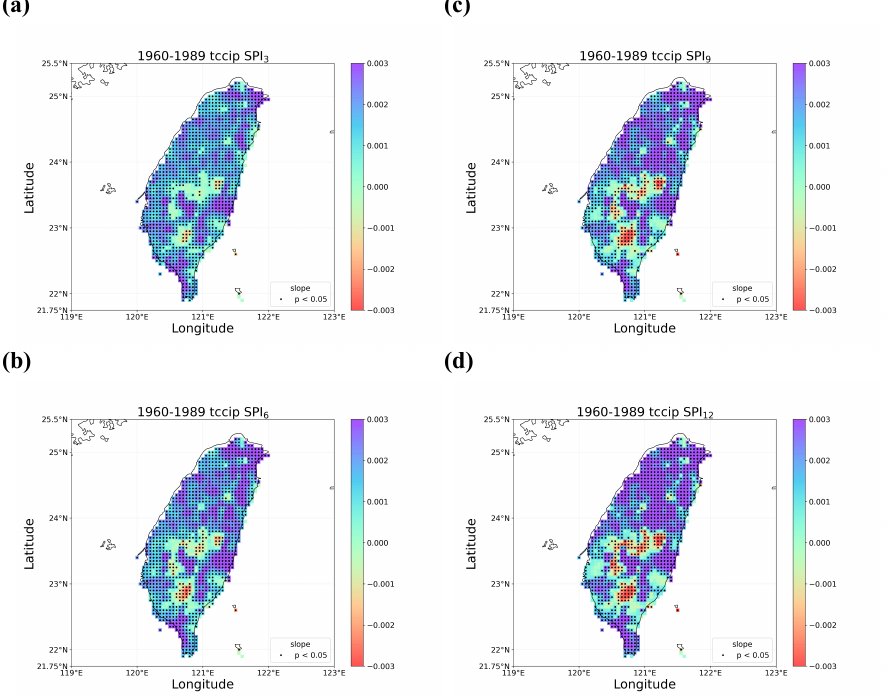
Figure 7. Spatial patterns of trends in the SPI series in the earlier period (1960–1989) detected using linear regression; ( a – d ) the SPI at 3-, 6-, 9-, and 12-month